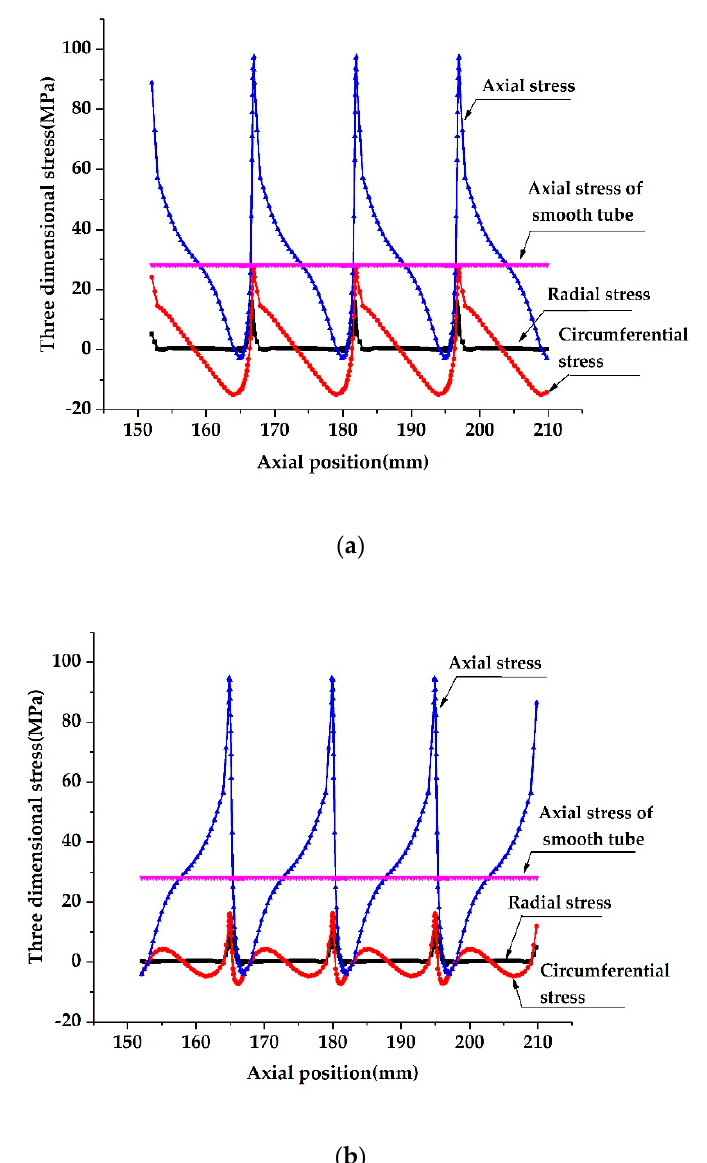
Figure 8. Stress distributions along tube length on inner and outer surfaces of the CD tubes: ( a ) On the outer surface, ( b ) On the outer surface. ( D = 25 mm, L 1 = 15 mm, t = 2.5 mm, H = 1.25 mm, F = 5000 N).